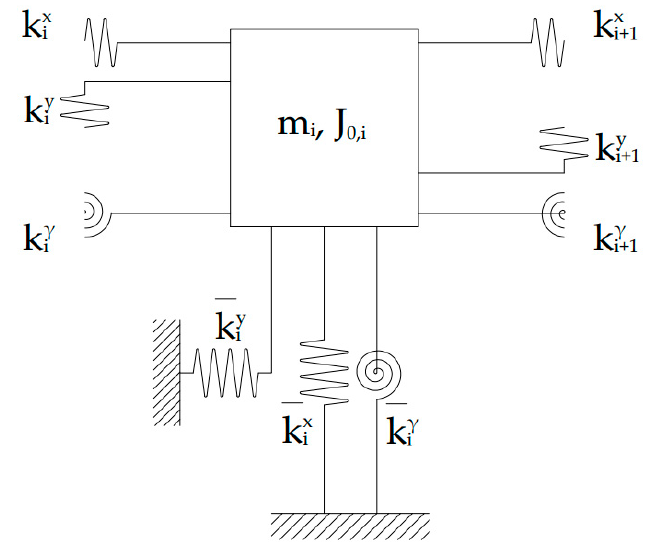
Figure 1. Lumped mass model of the interacting i-th diaphragm.